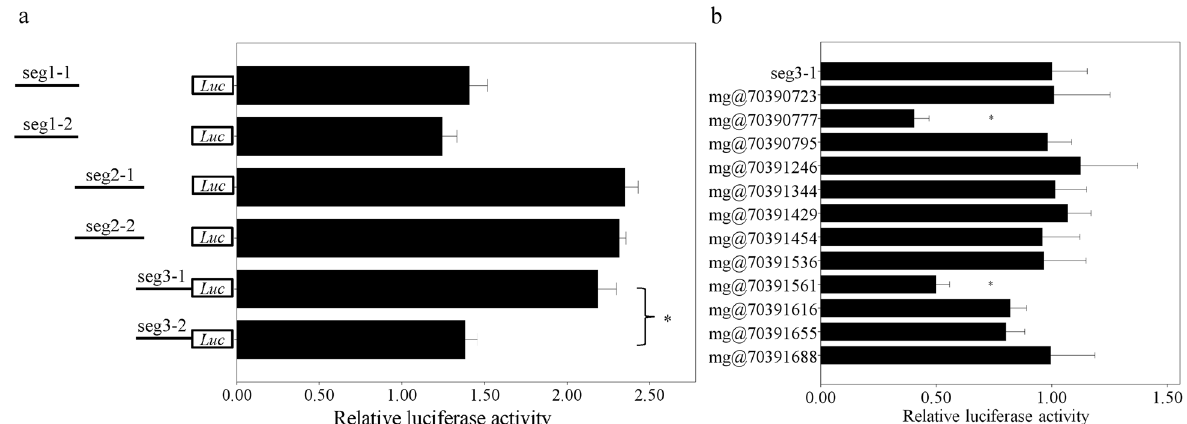
Figure 4. Function of the segments in chr4:70389000-70392000 ( a ) and mutations in seg3 ( b ). Each bar represents one plasmid. All data is displayed as mean ± standard deviation (SD). The x axis and * represent relative luciferase activity and P < 10 −6 , respectively. In part a, the lines in left indicate the relative location of the three segments. “Seg” is the abbreviation for “segment”. “−1” and “−2” represent core haplotype 1 and 2, respectively. The data is normalized to the read of empty vector (pGL3-promoter). For part b, the above plasmid (seg3-1) is the original construct while the below ones are from mutagenesis. Mg and the number after @ represent mutagenesis and SNP position in chr4, respectively. The data is normalized by the result of original plasmid